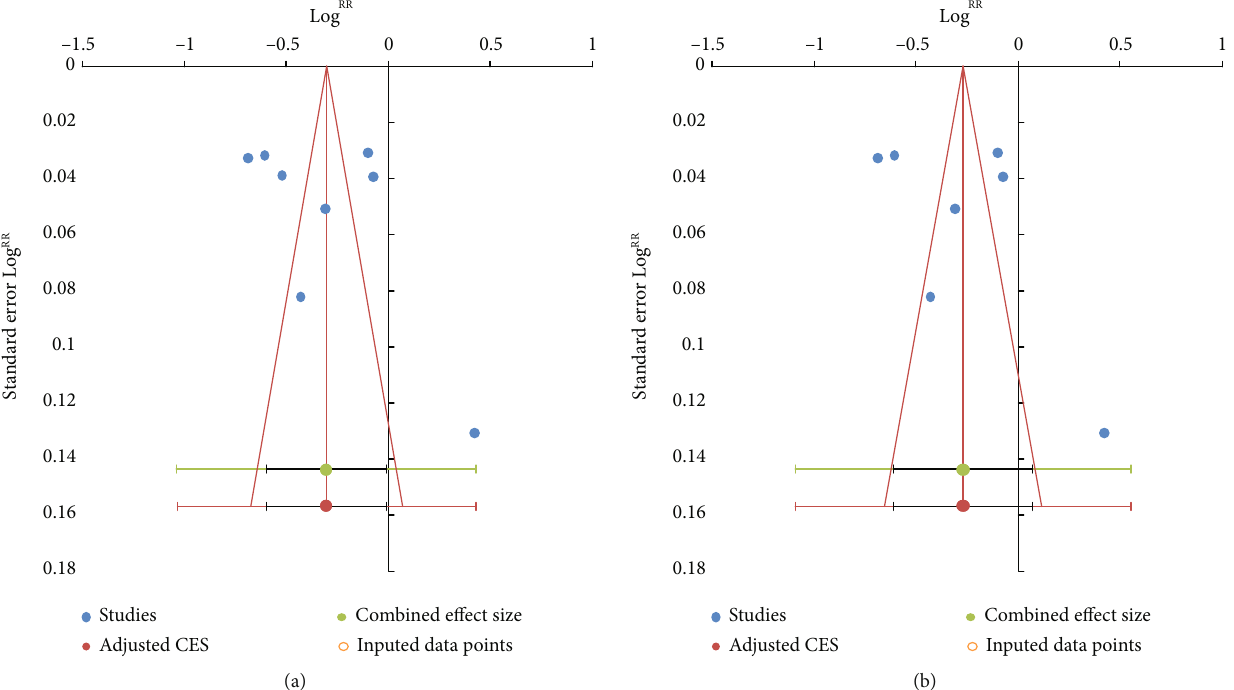
Figure 4: Funnel plot for publication bias in the study investigating the overall risk of cancer associated with the use of metformin monotherapy versus sulfonylurea using raw data (a) and using study-speci fi c (adjusted) RR estimates (b). Abbreviations: RR: relative risk; SE: standard